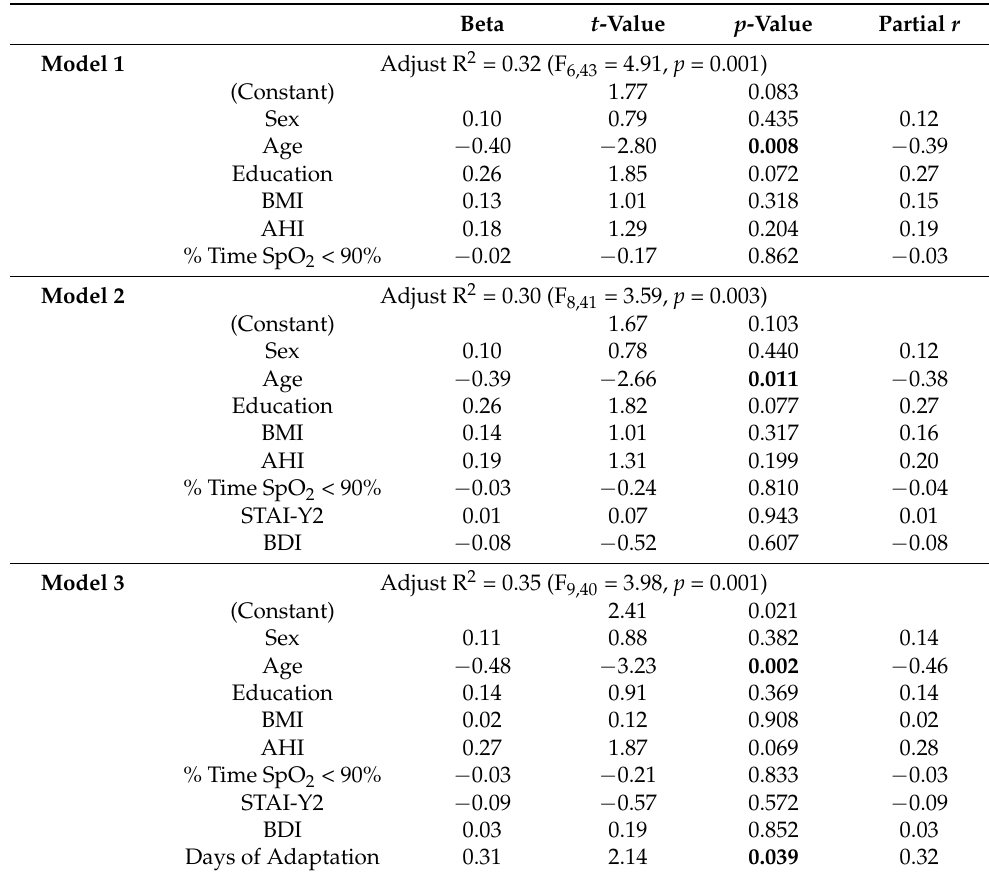
Table 3. Results of the hierarchical multiple linear regression analysis investigating the possible predictors of the long-term memory storage capacity (i.e., Selective Reminding Test—LTS score). Adjusted R 2 and F-statistics are reported for each model. Standardized Beta, t -values, p -values, and partial r correlation coefficients are reported for each predictor in each model. BMI: body mass index; AHI: apnea-hypopnea index; % Time SpO 2 < 90%: cumulative time spent with peripheral blood oxygen saturation (SpO 2 ) below 90%; STAI-Y2: State-Trait Anxiety Inventory form Y2; BDI: Beck Depression Inventory. Bold means significant results ( p ≤